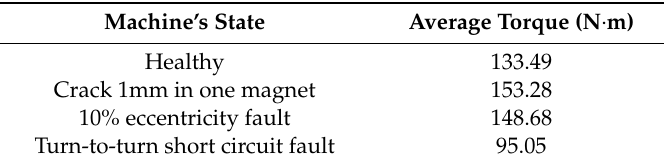
Table 2. Average torque for the di ff erent states of the